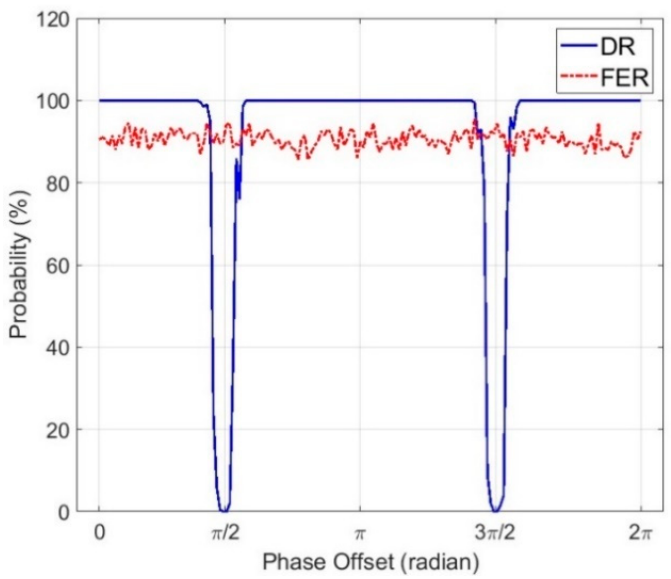
Figure 4. Detection rate (DR) and false edge detection rate (FER) versus phase offset ϕ m (assuming SNR = 35 dB), where a universal threshold-based detection is used. Table 2. Performance comparison (DR/FER (%)) of the proposed MV-based detection scheme for fixed and random PQDs, for which a sag signal of 80% pu is generated over Gaussian noise channel with SNR = 40 dB.